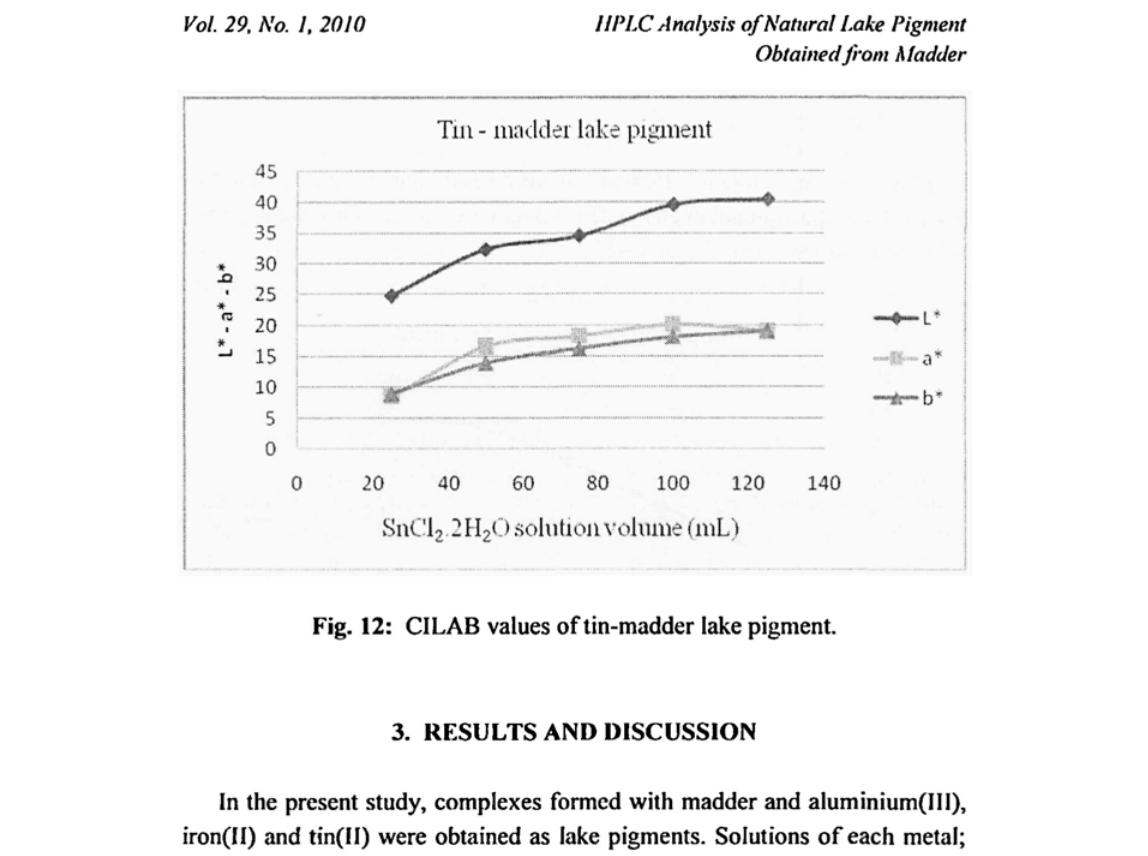
Fig. 12: CILAB values of tin-madder lake